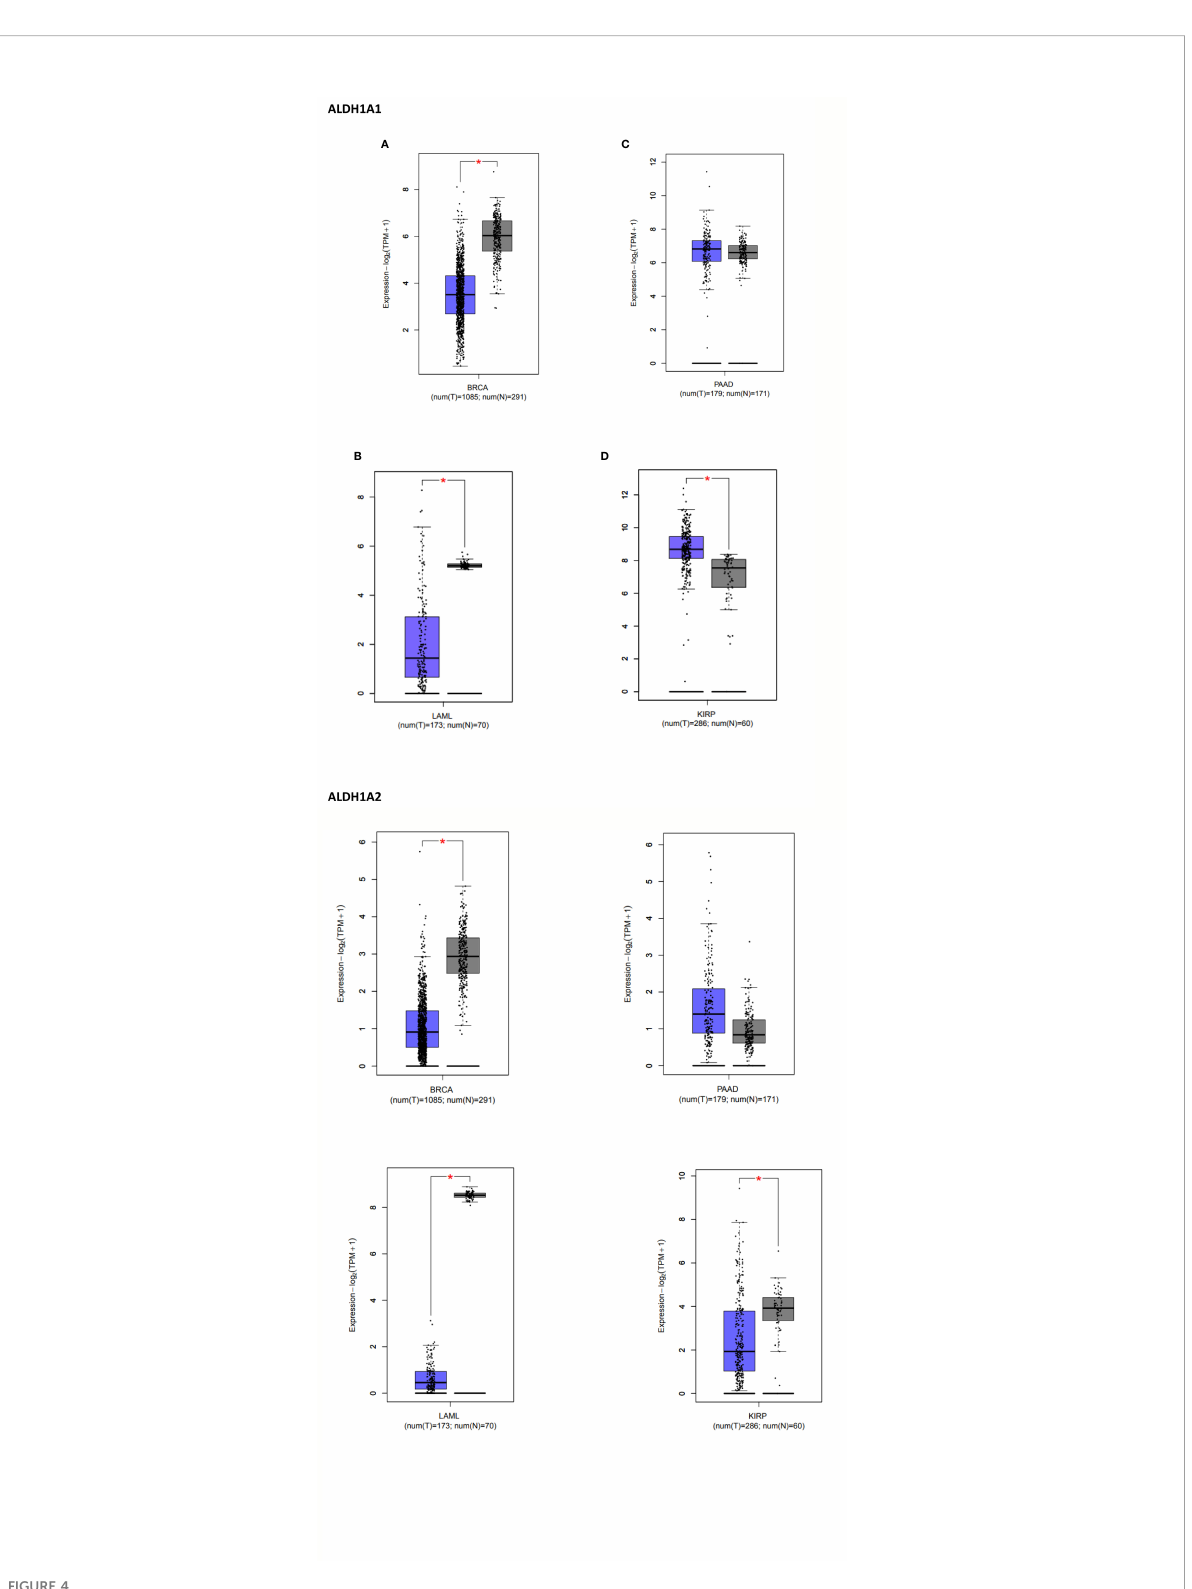
FIGURE 4 ALDH1A1 is differentially expressed in a cancer speci fi c manner with few cancers showing downregulation(LAML, BRCA, A, B ), upregulation (KIRP, C ) and no changes (PAAD, D ). TCGA data was analyzed using GEPIA